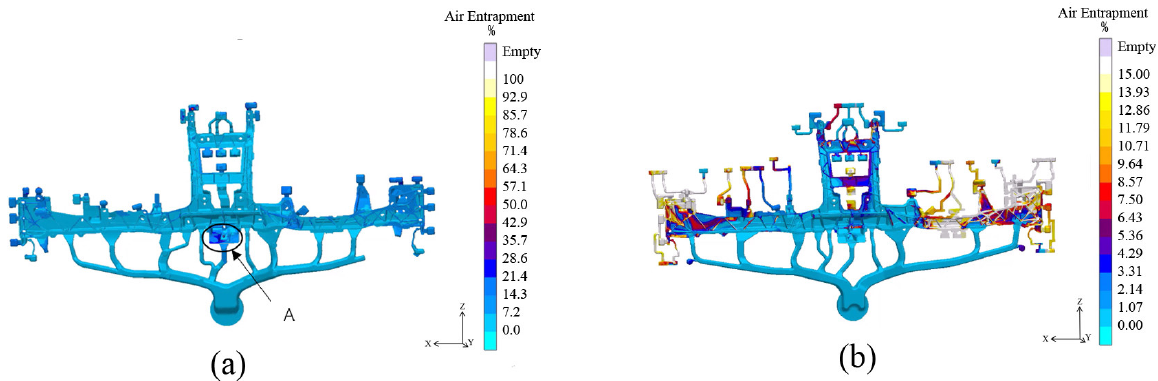
Figure 8. Comparison of air entrainment rate before and after optimization: ( a ) before optimization; ( b ) after optimization.